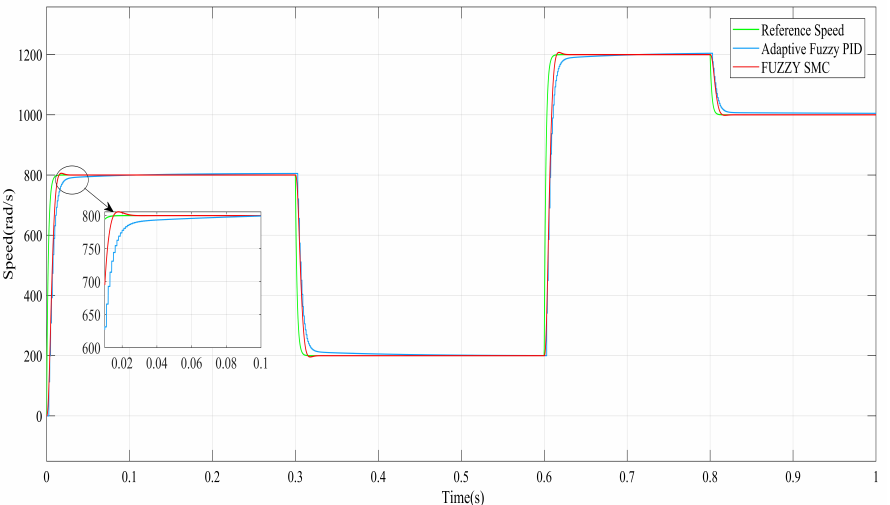
Figure 13. Measured and reference speed with adaptive fuzzy PID and fuzzy sliding mode controller.